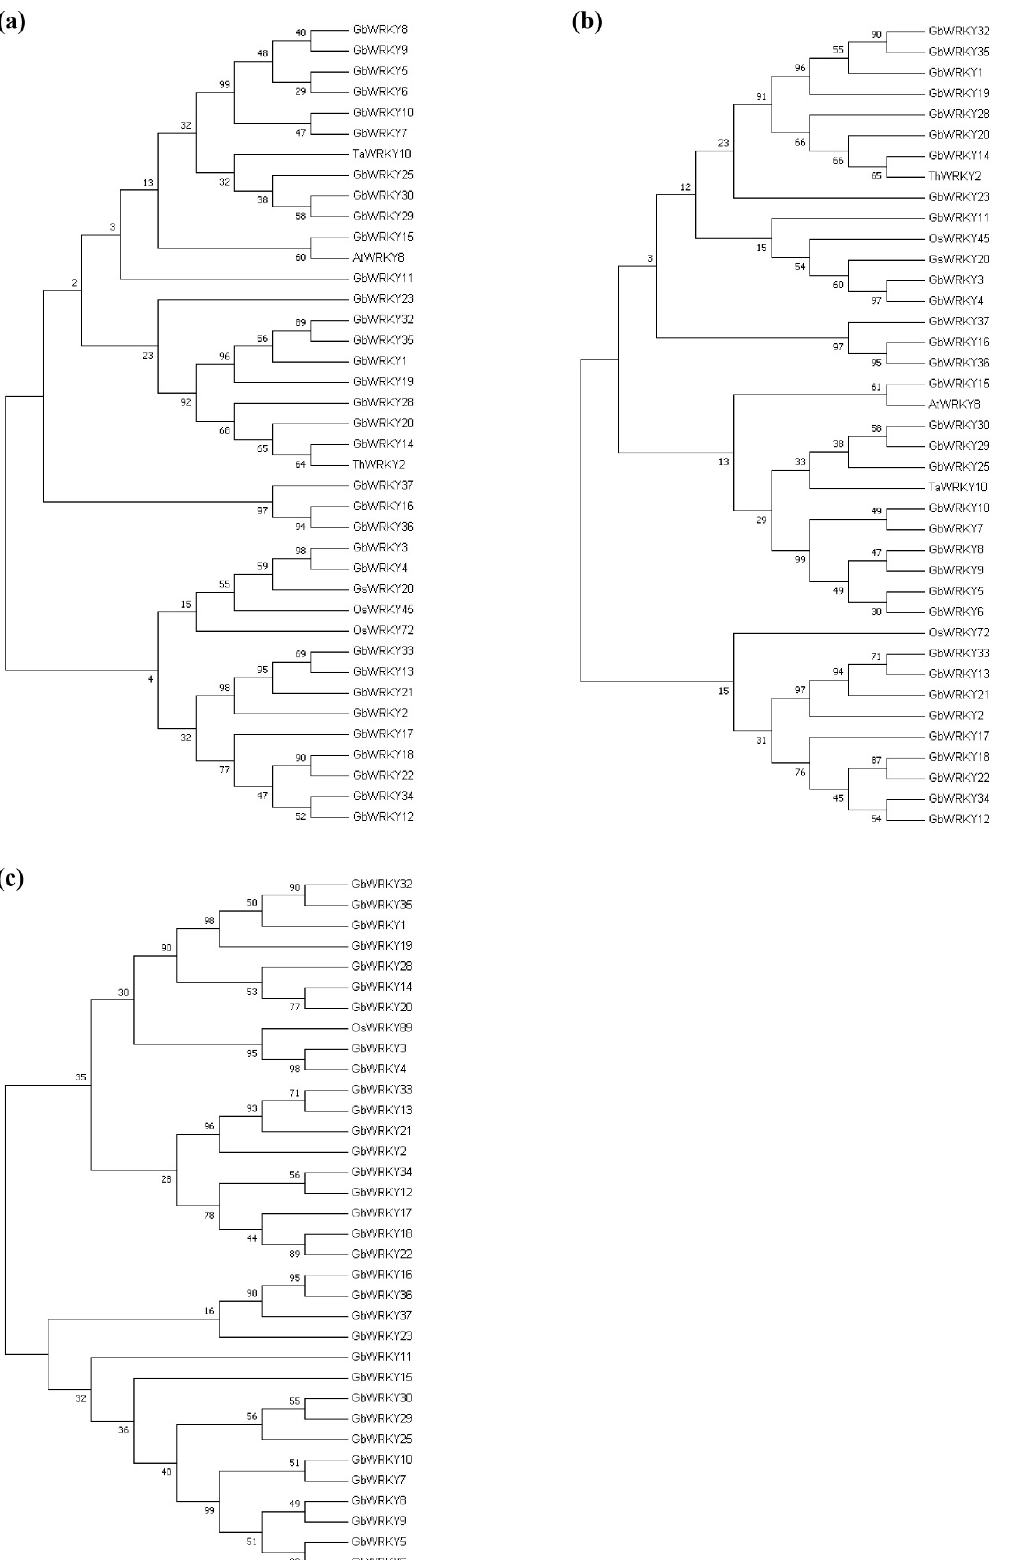
Figure 9. Phylogenetic tree analysis of GbWRKYs and known WRKYs related to salt ( a ), drought ( b ) and UV − B radiation ( c ).